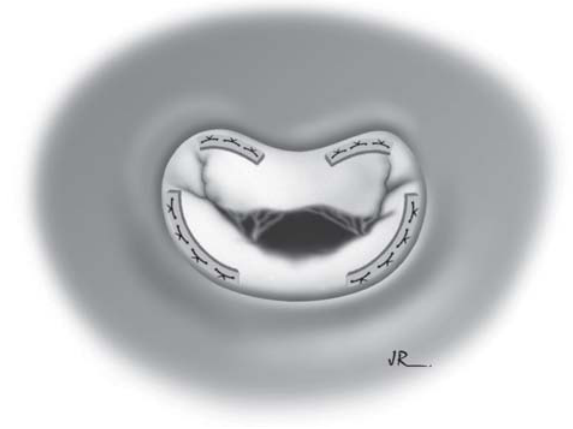
Fig. 1 - Anuloplastia intermitente: Realizam-se plicaturas com tira de pericárdio bovino nos diversos segmentos do anel